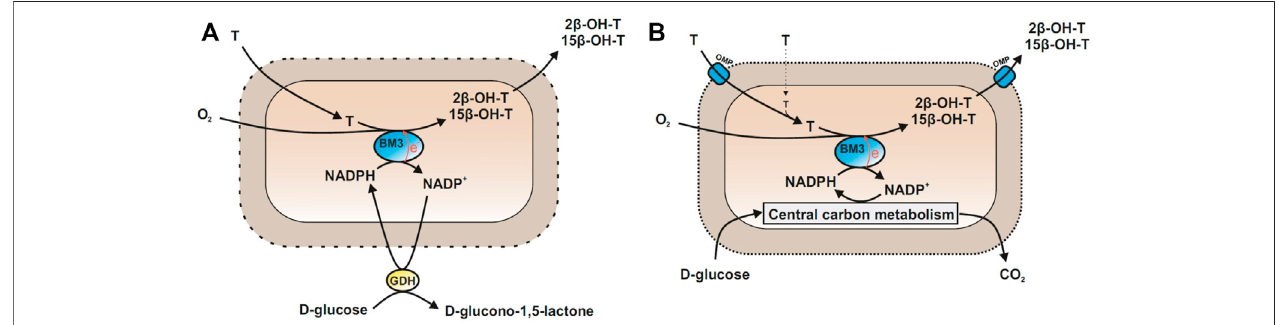
FIGURE 1 | Biocatalyst formats for the hydroxylation of testosterone (T) to 2 β - and 15 β -hydroxytestosterone (2/15 β -OH-T) using self-suf fi cient CYP450 BM3 variants (BM3). (A) Permeabilized cells supplied with glucose and glucose dehydrogenase (GDH) for NADPH regeneration. Ef fi cient steroid diffusion into cells can